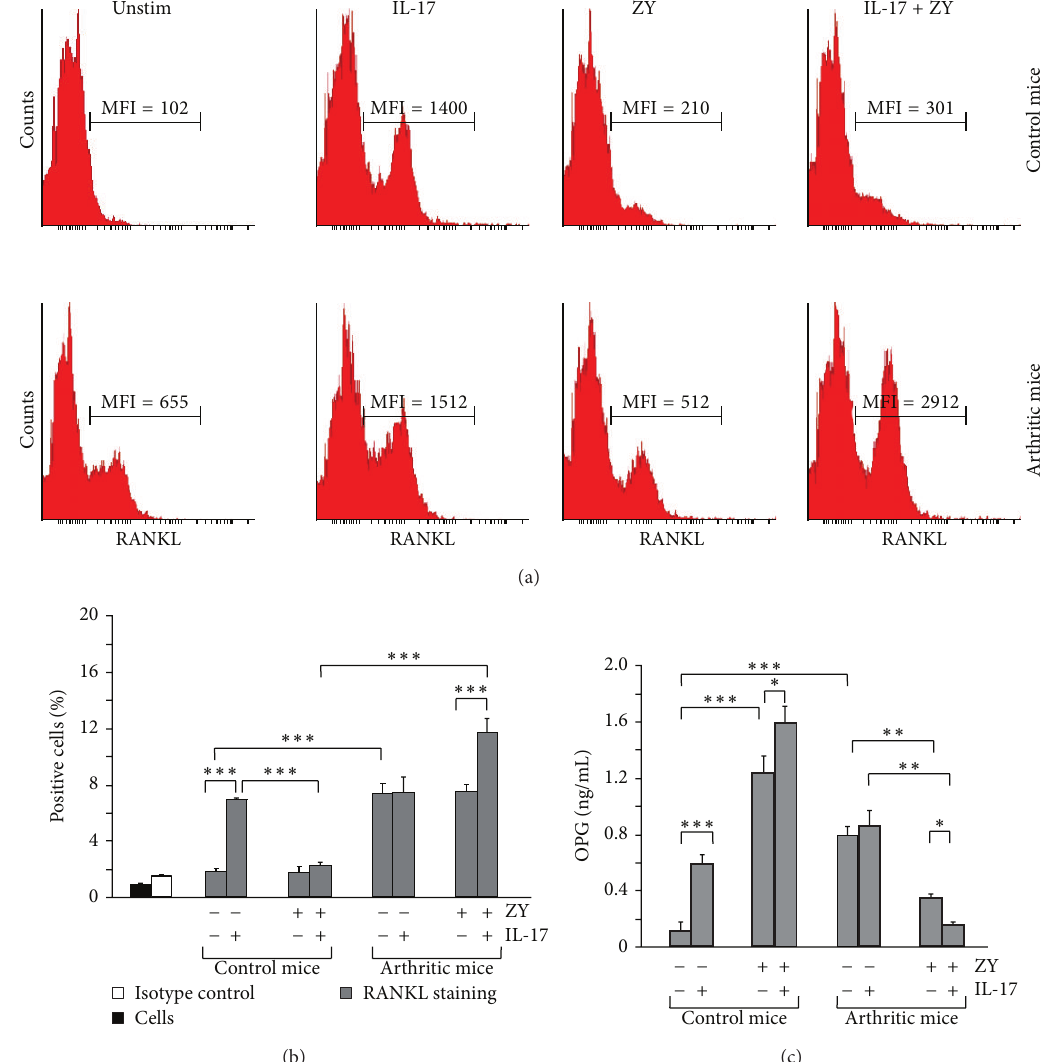
Figure5:RANKLexpressionandOPGsecretionbyneutrophilswereregulatedbyTLR2ligandandIL-17.Purifiedneutrophilswerestimulated as in Figure 3. (a) Representative histograms show RANKL expression on blood neutrophils from nonarthritic and arthritic mice. MFI: mean fluorescence intensity. (b) Graphs indicate that IL-17 increases the frequencies of RANKL + neutrophils in the control group. More RANKL + cells are found after stimulation with TLR2 and IL-17 in arthritic group. (c) IL-17 and zymosan induce OPG secretion by control neutrophils and inhibit OPG production by cells from arthritic mice. Values in (b) and (c) are the mean ± SEM ( 𝑛 = 5 animals/group; 3 experiments). ∗ 𝑃 < 0.05 ; ∗∗ 𝑃 < 0.01 ; ∗∗∗ 𝑃 < 0.001 , Student’s 𝑡